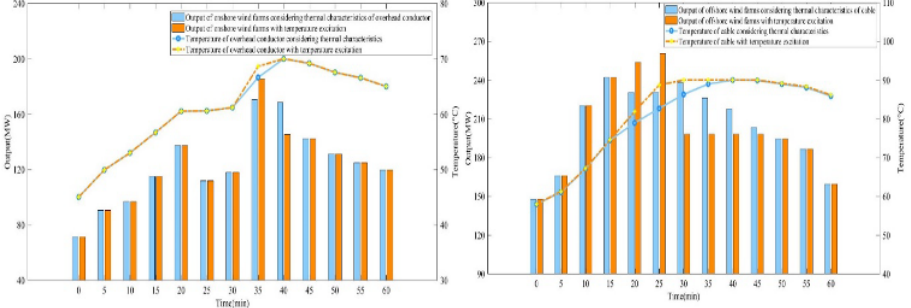
Fig. 5. Simulation results of onshore wind farms. Fig. 6. Simulation results of offshore wind